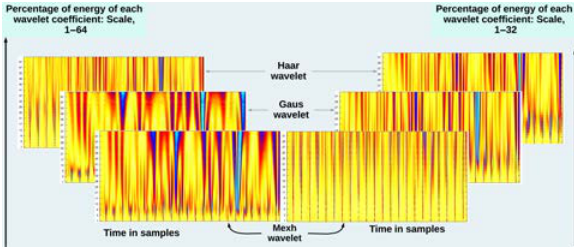
Fig. 13 Data generated using the “mexh” and “cgau2” wavelets.